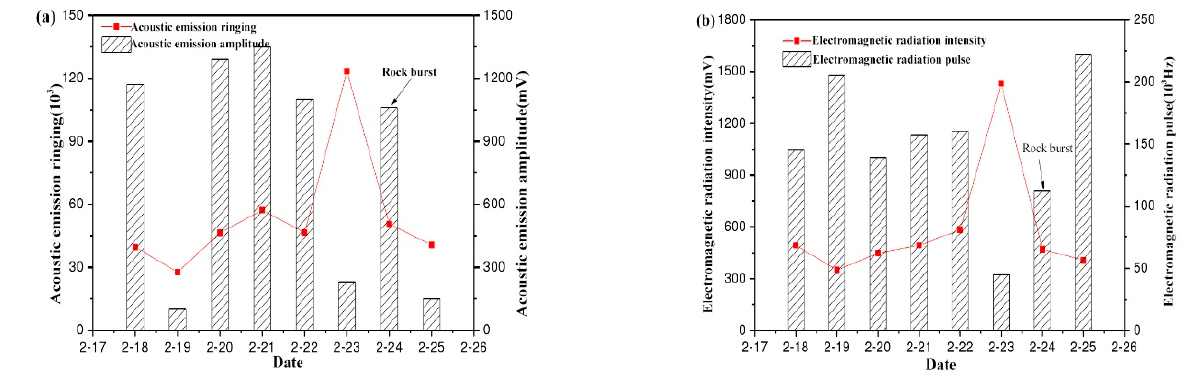
Figure 6. ARAMIS M/E microseismic rule of rockburst. ( a ) On 24 February 2014; ( b ) On 12 July 2014.